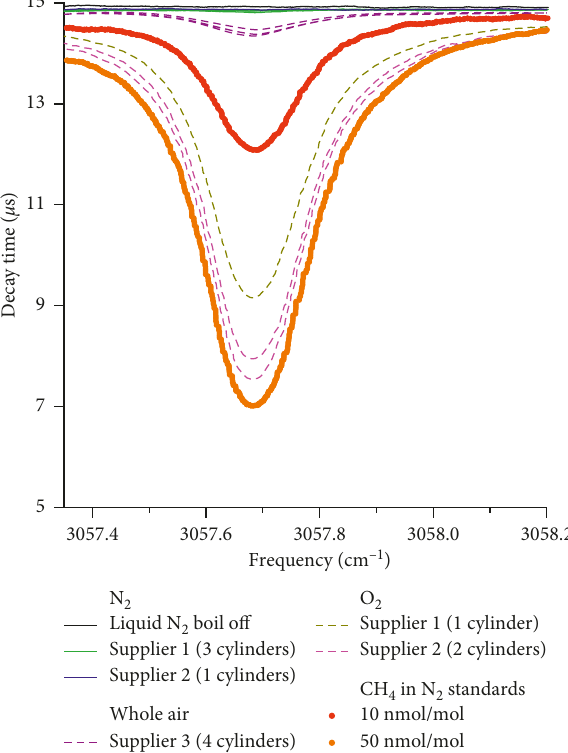
Figure 3: Purity analysis for methane in the matrix gases N and whole air from different suppliers. In addition, the mea- surement of two CH 4 reference standards (10 and 50nmol/mol in N 2 ) is